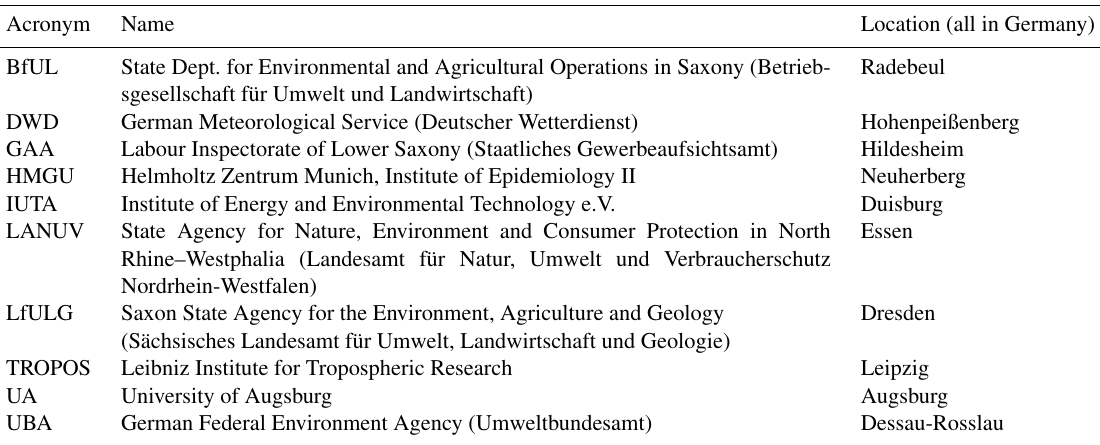
Table 5. Institutions involved in GUAN, in alphabetic order.